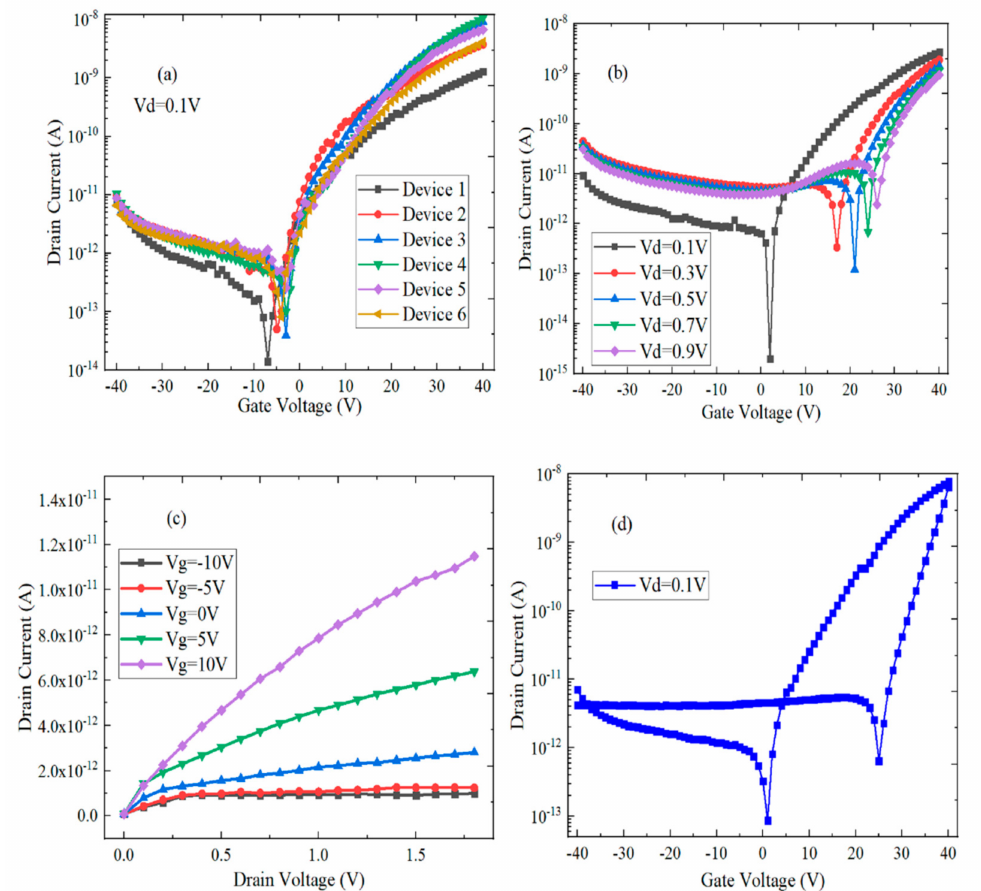
Figure 8. Electrical performance test of WS 2 /h-BN FET device. ( a ) Transmission characteristic curves (Id-Vg) of different devices; ( b ) Transmission characteristic curves (Id-Vg) under different drain voltages (Vd); ( c ) The output characteristic curve (Id-Vd) under different gate voltages (Vg); ( d ) Bidirectional transmission characteristic